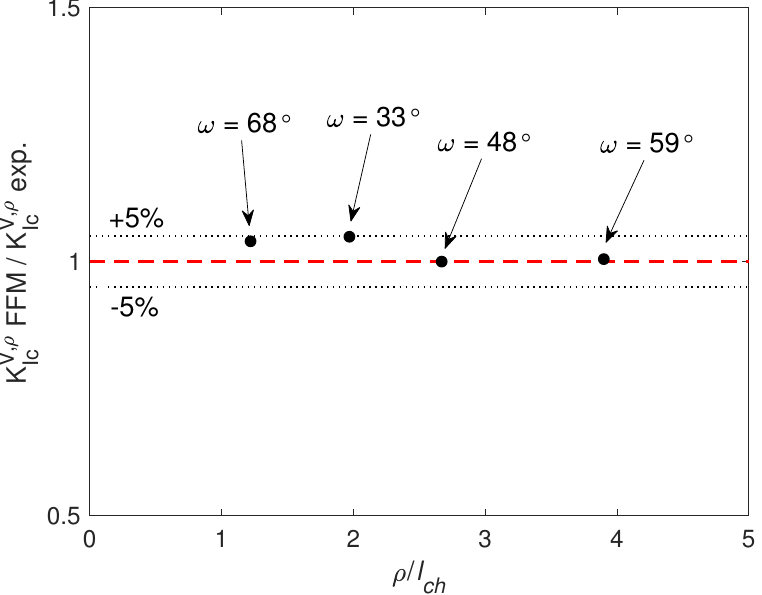
Figure 5. Comparison between experimental (denoted by exp. ) and Finite Fracture Mechanics (FFM) apparent generalized fracture toughness for the considered nano-cantilevers. The ratio is plotted against the dimensionless notch root radius. Table 4. Comparison between experimental (denoted by exp. ) and FFM apparent generalized fracture toughness (MPam 1 − λ ) for the considered nano-cantilevers. For the sake of clarity, dimensionless values of the notch root radius are reported as well, where l ch = ( K Ic / σ u ) 2 ≈ 5.18 nm. K V , ρ FFM K V , ρ ω (deg) ρ / l ch K V Ic Ic Ic